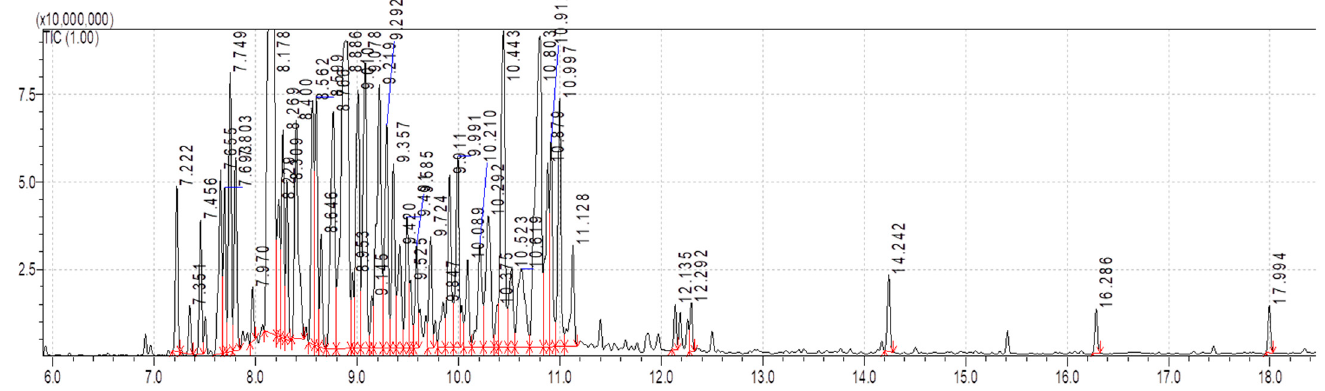
Figure 9. GC-MS/MS Chromatogram of volatile (VO) root bark of T. ciliata. The structure of some of the major compounds, according to their percentages iden- tified in volatile oil, are listed below Santalene (8.55%), Himachalol (6.69%), Longicyclene (5.05%), Cadina-1(10),4-Diene (4.1%), Amorphene (3.24%), Dihydroagarofuran (2.62%), Cubenol (2.58%), 3,11-Acoradiene (2.21%), Neoisolongifolene (2.21%), Ylangenol (2.12%), [5-(Hydroxymethyl)-2,5,8a-trimethyl-1,4,4a,6,7,8-hexahydronaphthalen-1-yl]methanol 2.12%, Cyclosativene (2.04%), 1 (-)-Isolongifolol, acetate(1. 88%), β -Calacorene (1.46%), 4,9-Muuroladien-15-ol (1.2%), 5-Metoxy seselin, and Rutamarin (0.41%) (Figure 10). Most of the compounds presented in this study for the volatile oil of root bark were reported for the first time according to previous research on genus Toona [21,22]. During analysis of all the classes of compounds in NVOs and VO, the classes of chem- ical compounds were Sesquiterpene hydrocarbon, oxygenated sesquiterpene, furanocou- marins, and hydrocarbon alcohol, all of which are present in both NVO and VO (Table 14). Table 14. Summary of class of compounds with percentage abundance.